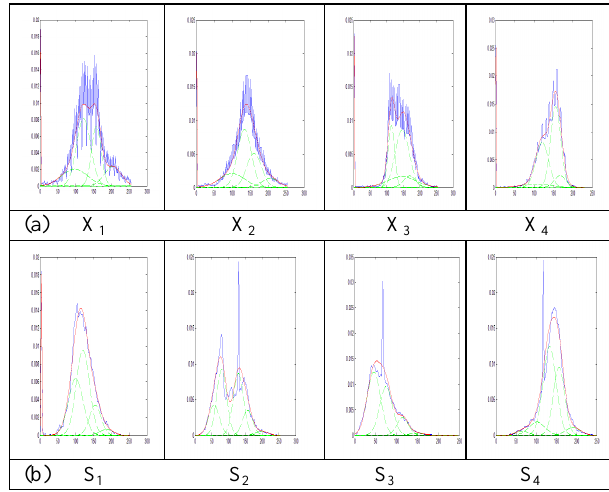
Figure 4. Data distributions before (a) and after non linear source separation(b)